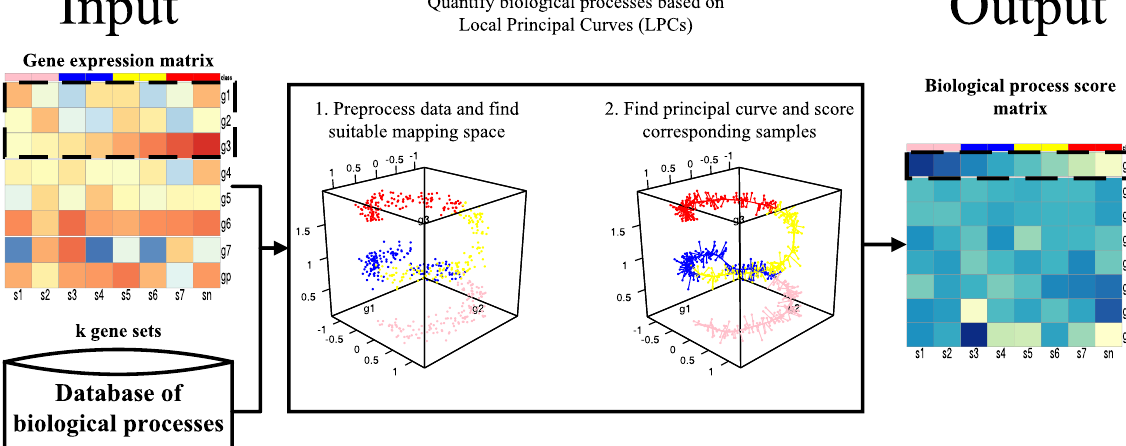
Figure 1. An example of quantifying biological processes based on Local Principal Curves (LPCs) algorithm. The input for the proposed method are a simulated gene expression matrix with n samples and p genes, and k biological processes we concern. 1) For selected biological process, we preprocess expression matrix of these three genes involved in by Principal Component Analysis (PCA), and then, and we then choose suitable Principal Components (PCs) to construct mapping space (see Method). To keep things simple, we here identify gene with PC. The plot intuitively illustrates the distribution of samples in mapping space consisting three PCs. 2) We stretch LPC with a starting point and compute projection indices for samples as Biological Process Scores (BPSs). (see Method). The plot illustrates a well-defined curve passes through data cloud with samples projecting onto corresponding position on the curve. The output of the proposed method is a matrix consisting of